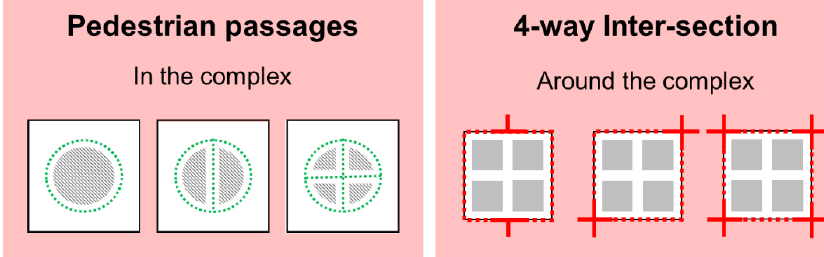
Figure 4. Parameters of the AI.